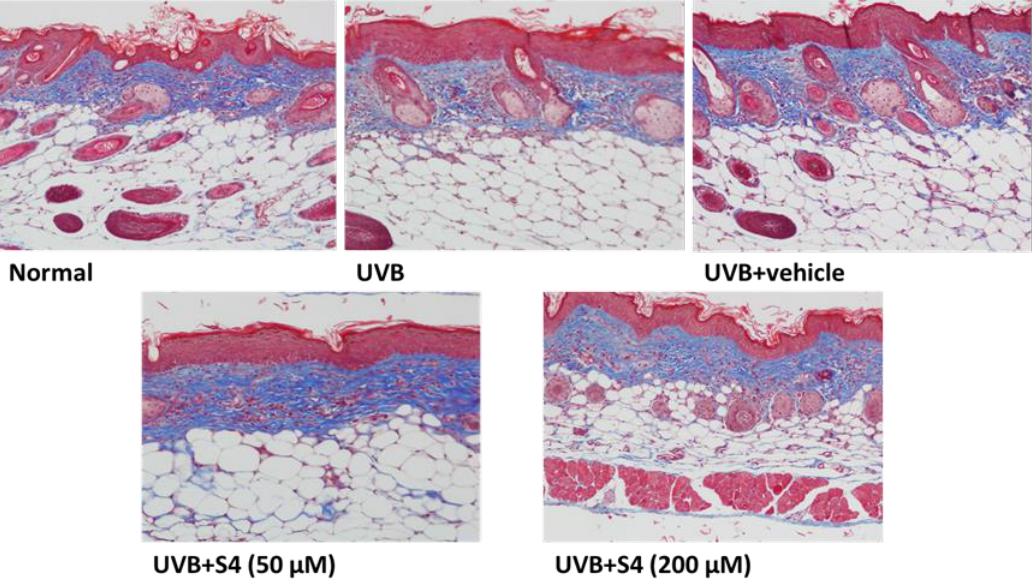
Figure 14. Light micrographs of histological sections stained with Masson’s trichrome in hairless mice. Collagen fibers were stained in blue.